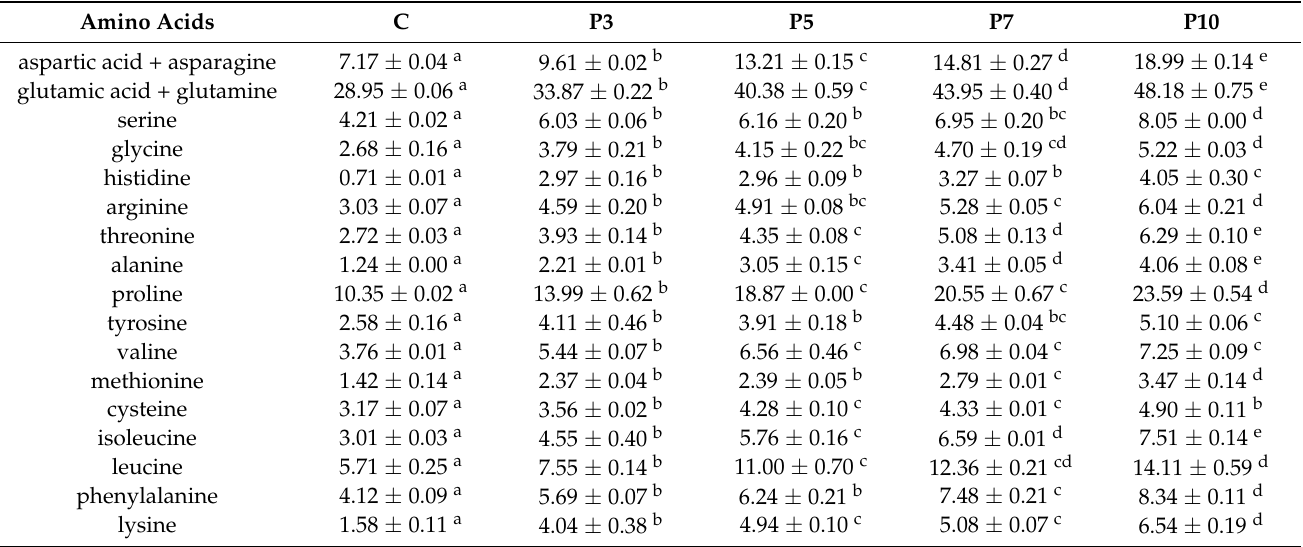
Amino acids [mg/g dry matter] profile of the pasta samples supplemented with spirulina